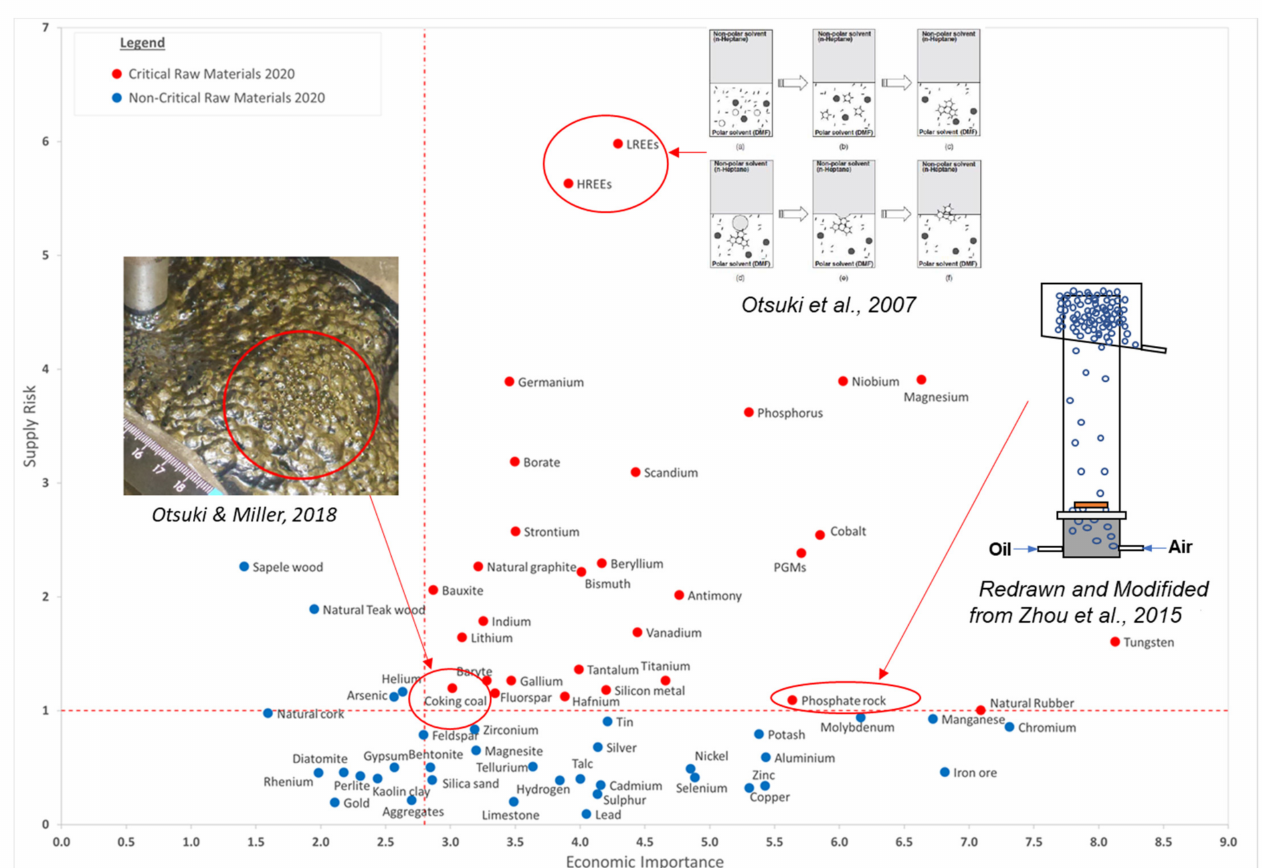
Figure 1. Economic importance (EI) and supply risk (SR) results of 2020 criticality assessment, reprinted with permission from [5]. Copyright 2020 European Commission, together with previous reports on flotation application to recover some CRMs adapted from